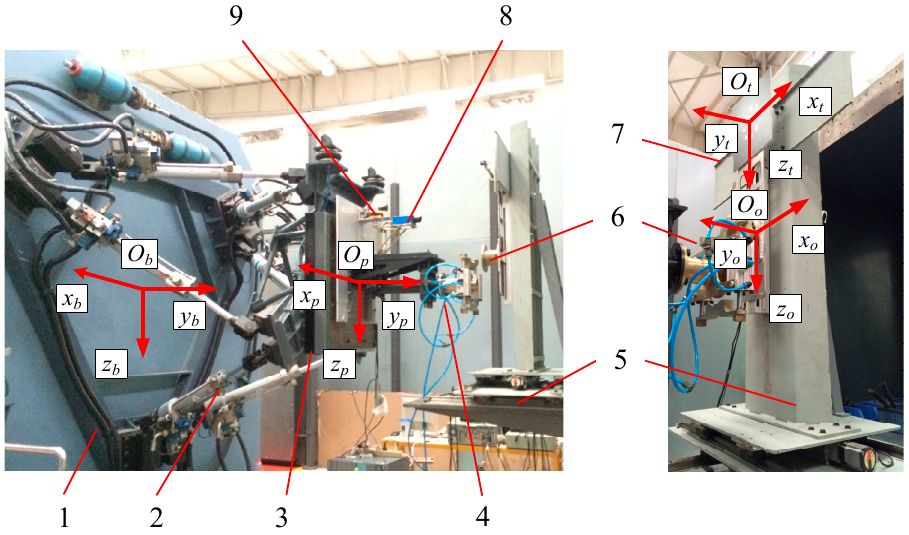
Figure 2. Hydraulic manipulator and simulation device: 1, platform basement; 2, HPM; 3, force sen- sor; 4, end-effector; 5, slideway; 6, target object; 7, planar pattern; 8, laser rangefinder; 9, CCD cam-